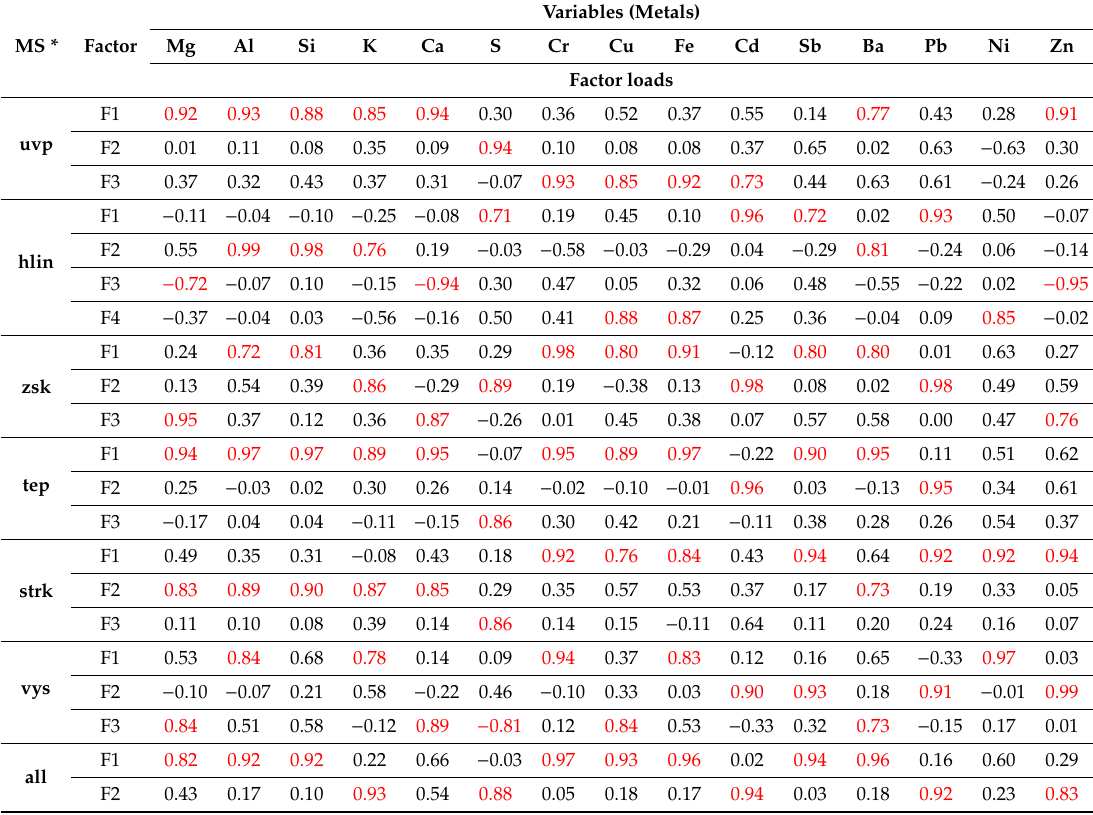
Table 3. Factor analysis results for all measuring stations and all measuring stations together, including the number of factors and chemical element factor